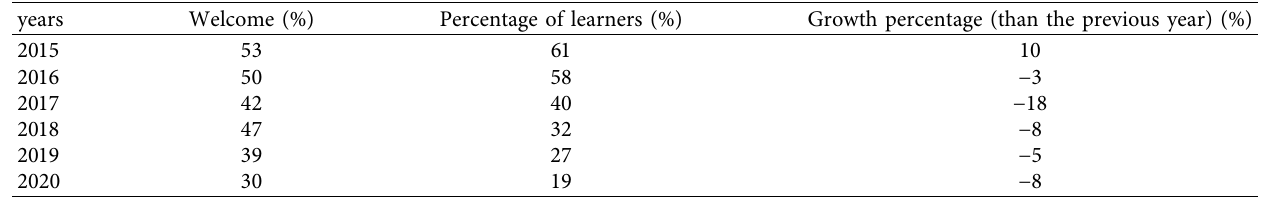
Figure 8: Problems in the development of traditional dance and characteristics of new media dance. (a) Problems existing in the de- velopment of traditional dance and (b) characteristics of new media dance. Table 3: The development trend of traditional dance from 2015 to 2020.